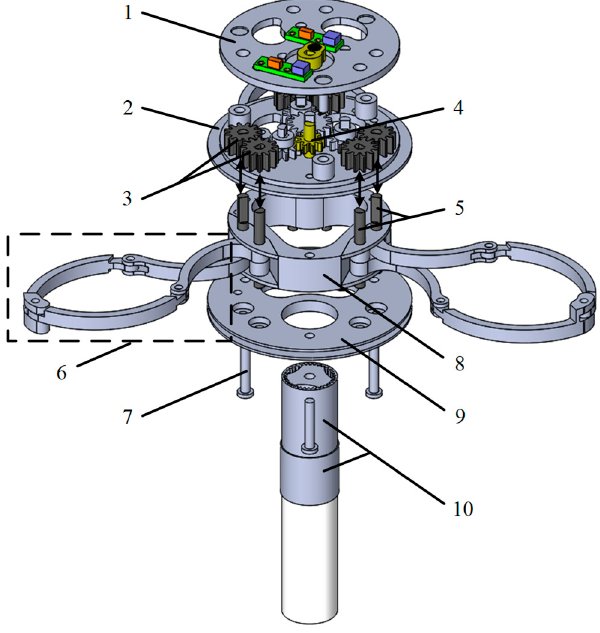
Figure 2. Structure of the expanding mechanism.